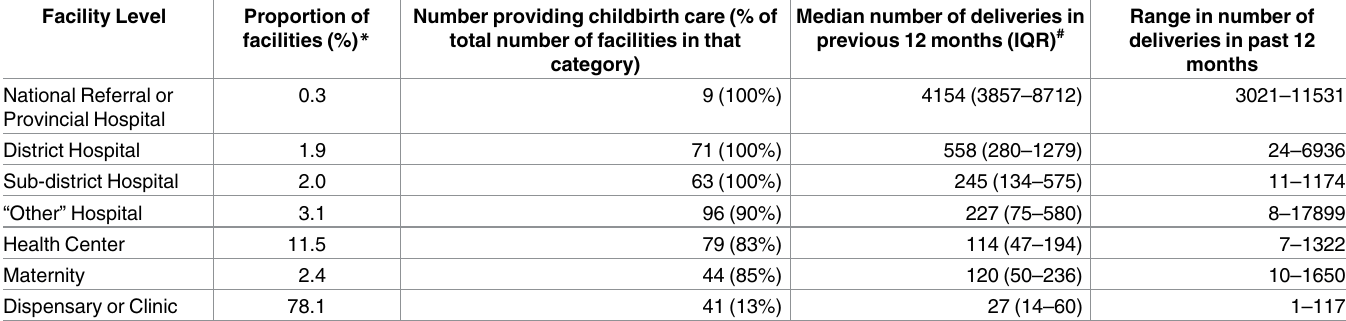
Table 2. Distribution of deliveries in the 2010 Kenya SPA by facility level.